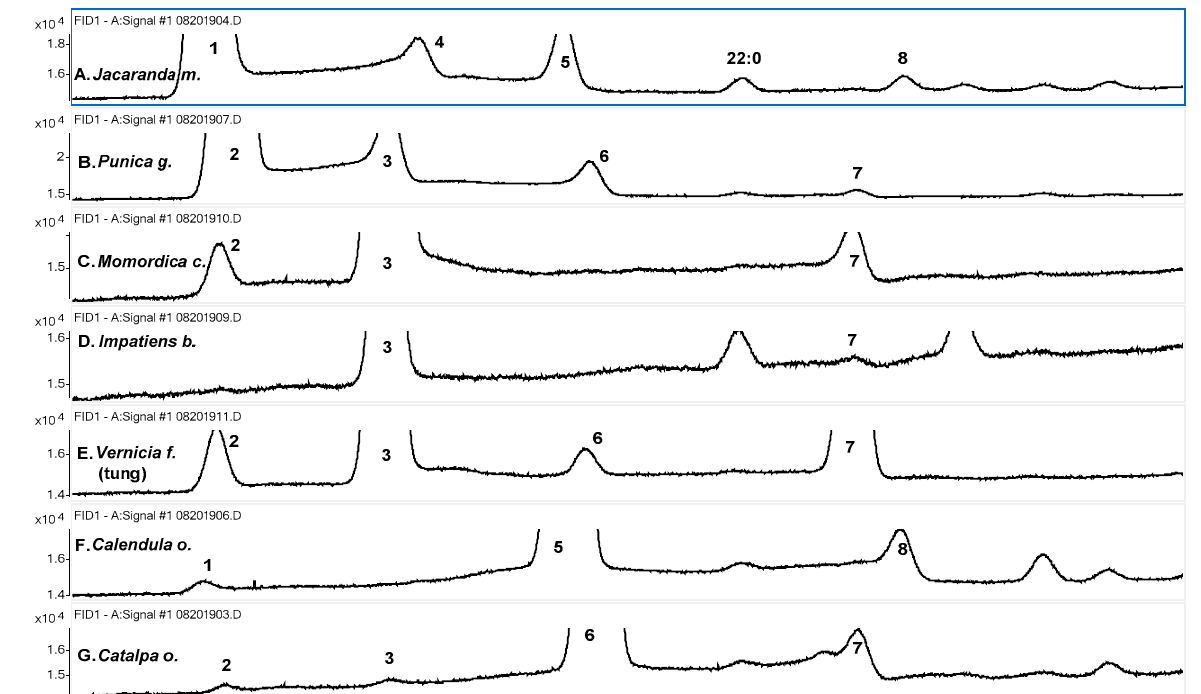
Figure 5. CLNA Regions of FID chromatograms of FAME of seven samples obtained using the Omegawax 250 column. Samples diluted compared to normal analysis levels to facilitate retention time matching. Numbered peaks are FAME of 1. Jacaric acid (8 c ,10 t ,12 c ); 2. Punicic acid (9 c ,11 t ,13 c ); 3. α -eleostearic acid (9 c ,11 t ,13 t ); 4 . Probable 8 c ,10 t ,12 t -18:3; 5 . α -calendic acid (8 t ,10 t ,12 c ); 6 . Catalpic acid (9 t ,11 t ,13 c ); 7 . β -eleostearic acid (9 t ,11 t ,13 t ); 8 . β -calendic acid (8 t ,10 t ,12 t ). Grouping numbered peaks according to geometric configuration: peaks 1 and 2 are ctc ; peaks 3 and 4 are ctt ; peaks 5 and 6 are ttc ; and peaks 7 and 8 are ttt .